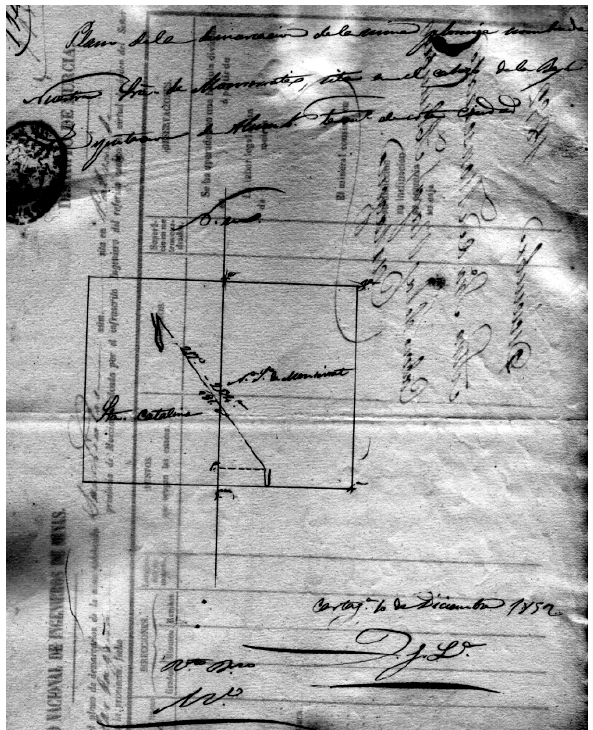
Figure 2: Original map of the claim (source: Directorate- General for Industry, Energy and Mines of the Autonomous Region of Murcia)